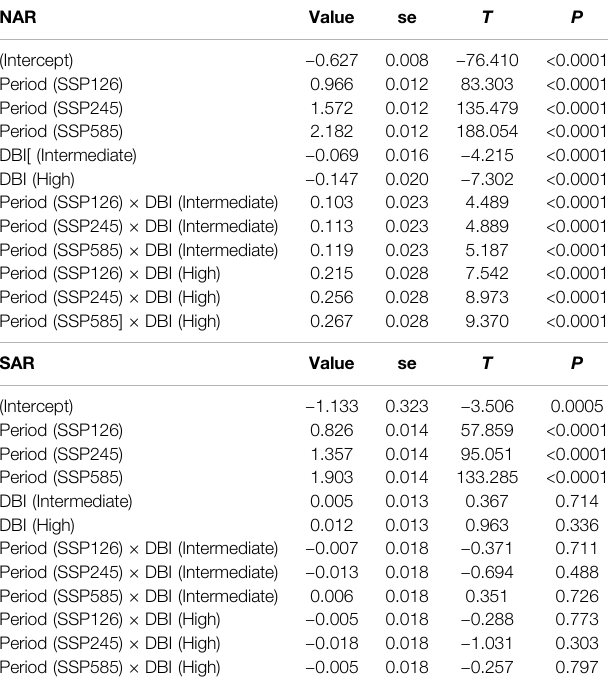
TABLE 1 | Summary statistics of the generalized least squares model assessing the difference in the change in average annual temperature across past and future periods in the surveyed localities of odonate assemblages with varying DBI levelsinNorthAfricanandSouthAfricanregions.PastperiodandlowDBIareused as baseline levels. R-squared was 0.98 in NAR and 0.97 in